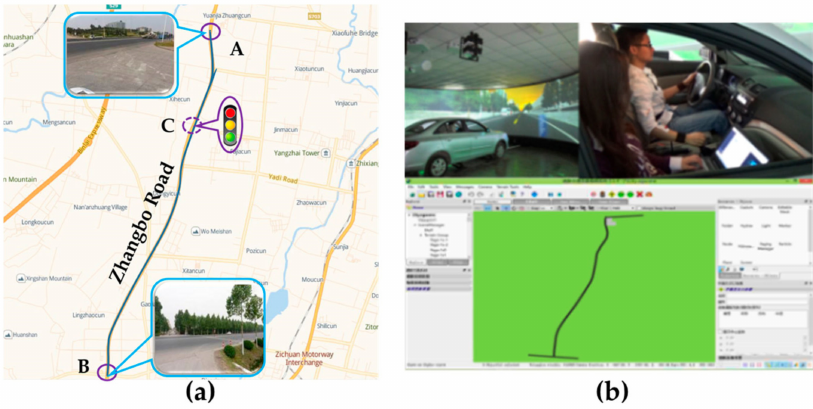
Figure 2. Experiment route. ( a ) Actual driving route; ( b ) Virtual road section.